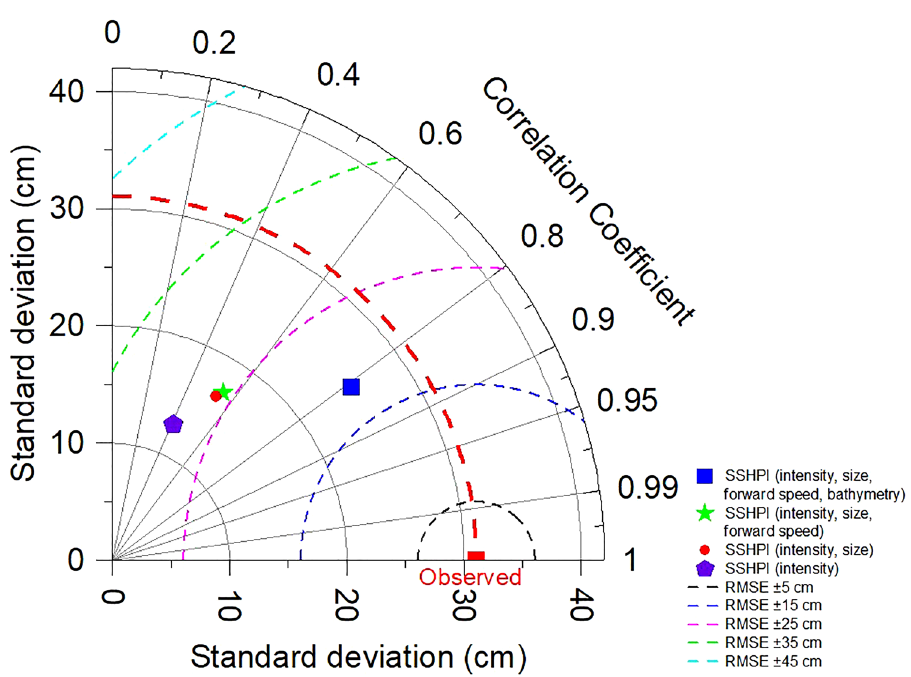
Figure 5. Taylor diagram describing the performance of SSHPI by comparing with the reduced versions of SSHPI. The azimuthal angle represents correlation, the radial distance the standard deviation, and the semicircles centered at the “Observed” marker the root mean square error. The red dashed line constitutes the standard deviation of observed peak storm surge heights (n =